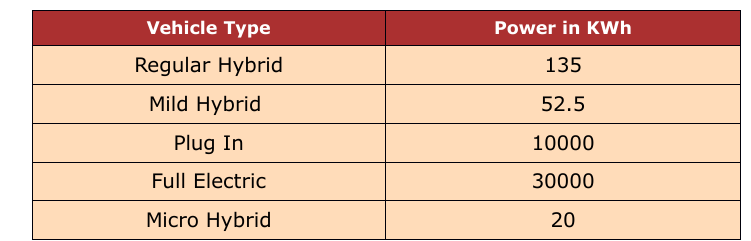
Table 5. Average Battery Power